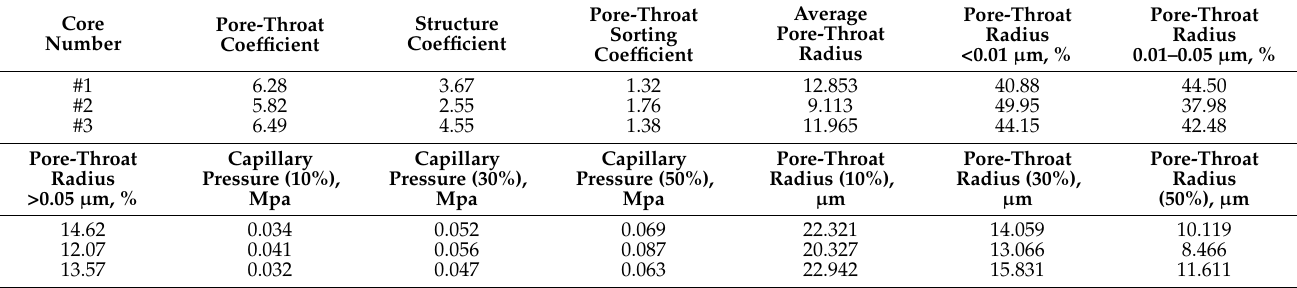
Table 3. Distribution and structure of pore-throats before and after water/FeRM